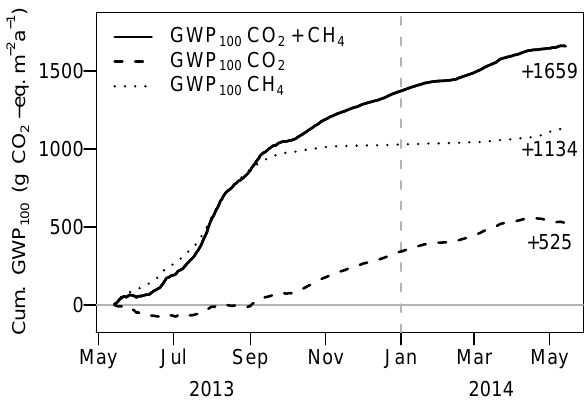
Figure 4. Cumulative GWP 100 budgets of CO 2 (based on ) , CH 4 (based on NLR CH MDS CO 2 nofoot both for the EC source area during the observation